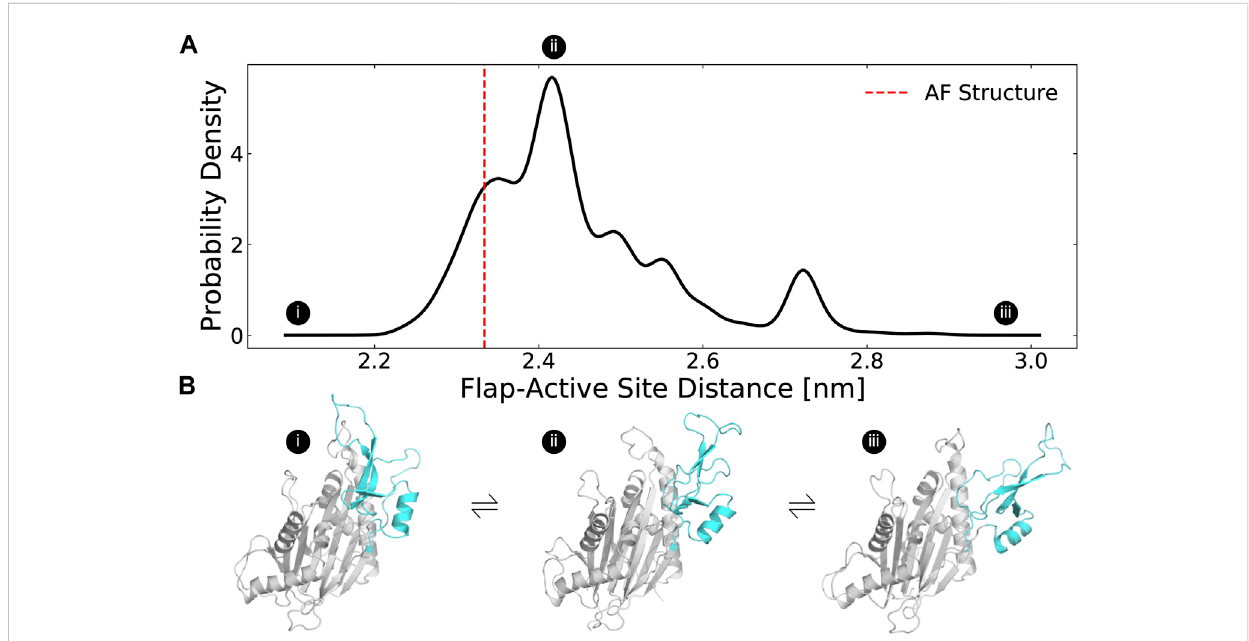
FIGURE 2 The distribution of fl ap domain to active site distances from MD simulations highlights that the fl ap is a highly fl exible domain that can adopt more open conformations than seen in the AlphaFold-predicted structure. (A) The MSM-weighted distribution of average distances between the fl ap domain (de fi ned as residue 219 – 295) and the active site (residues 105, 192, 314, and 366) backbones shows two peaks as well as long tails that highlight low probability highly closed and highly open conformations. The dashed red line indicates the same distance measured for the